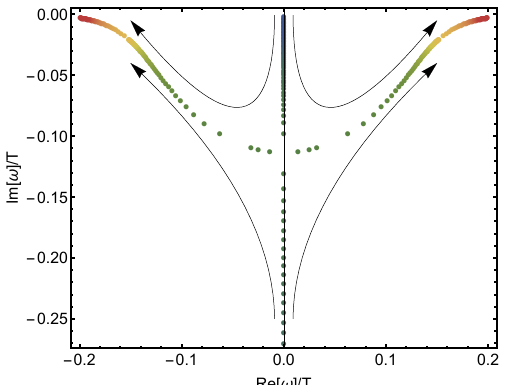
Figure 16 . The dynamics of the lowest two modes in the transverse sector for m=T = 0 : 3 ; (cid:11) = 0 : 05 and increasing the parameter (cid:12) from zero to large values. The collision between the two poles happens at (cid:12) (cid:24) 1 and it produces the two light pseudo-phonons with a (cid:12)nite real part and a small damping. The arrows guide the eyes in the direction of increasing (cid:12) .